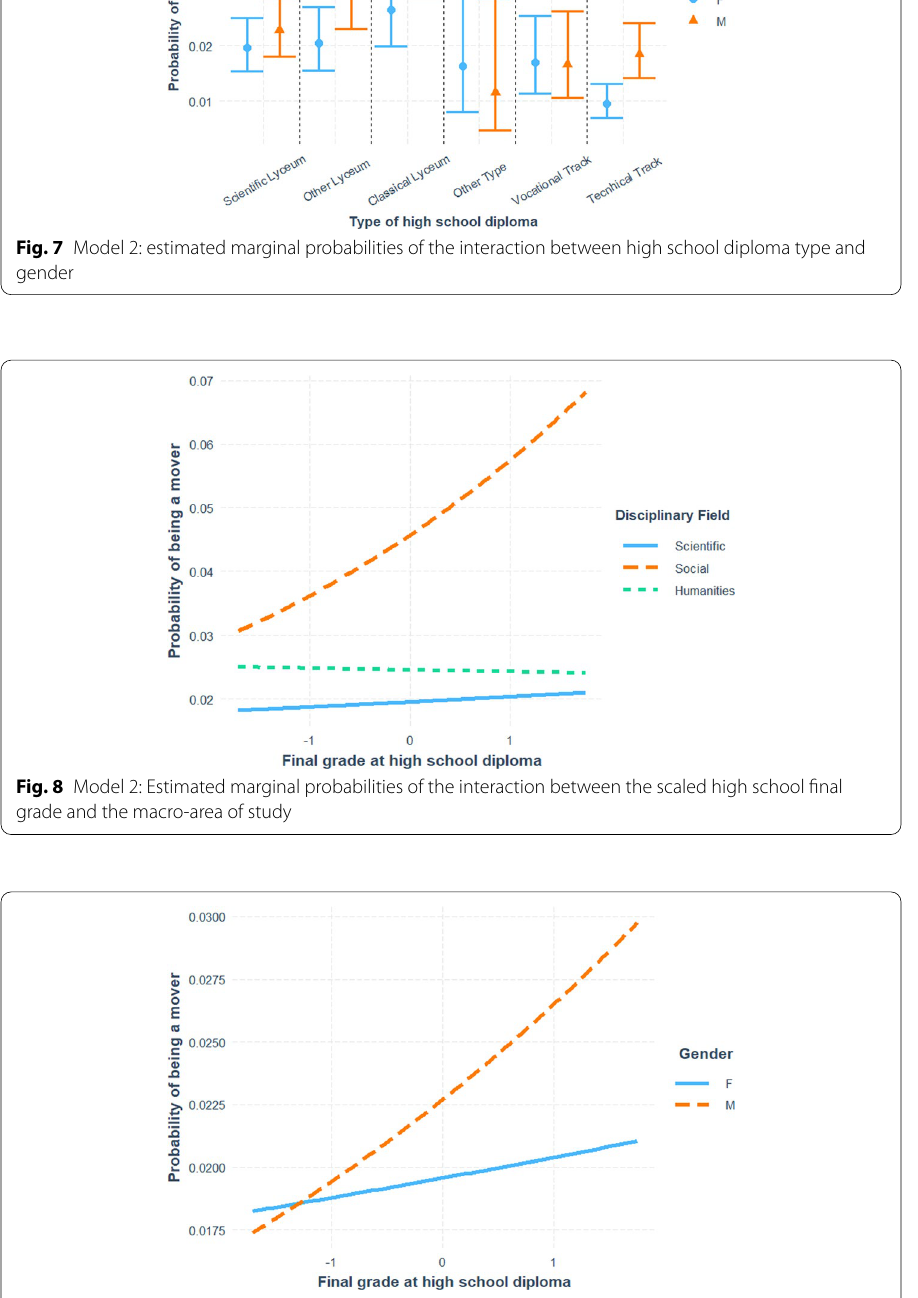
Fig. 9 Model 2: Estimated marginal probabilities of the interaction between the scaled high school final grade and the